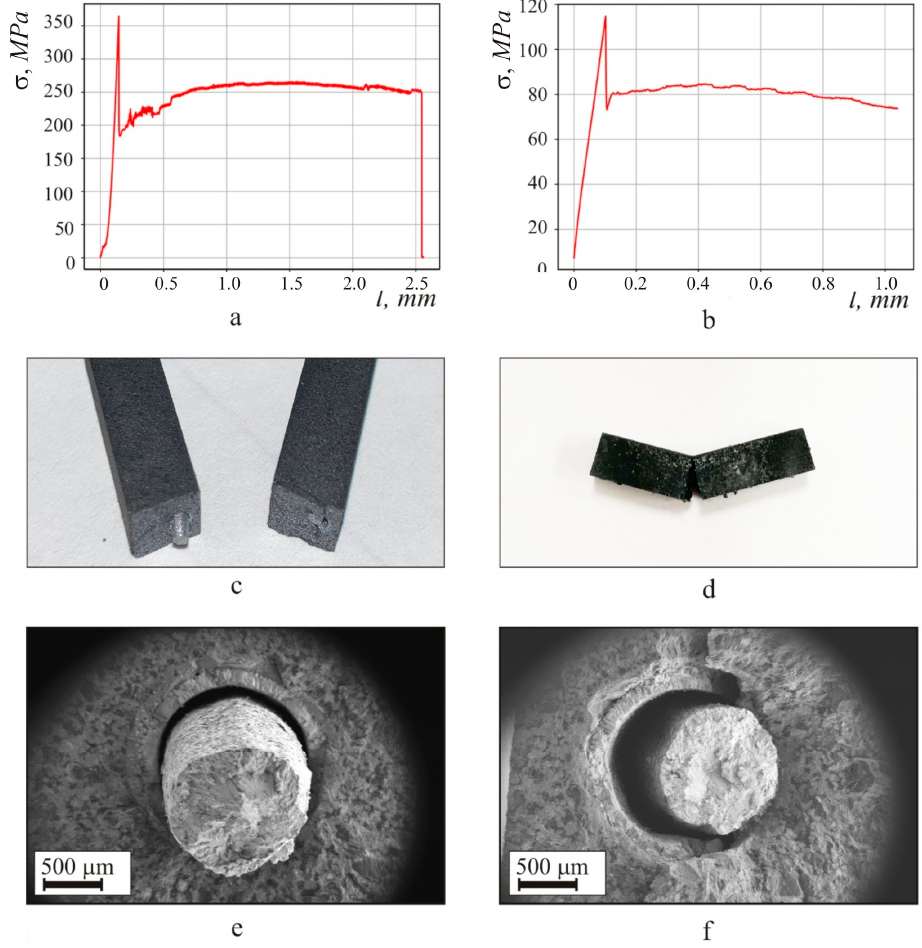
Figure 7. Loading diagrams: ( a ) sample 1–2 at room temperature and ( b ) sample 2–2 at 1500 °C. Photographs of samples after testing: ( c ) sample 1–2 at room temperature and ( d ) sample 2–2 at 1500 °C. ( e , f ) Micrographs of failure surfaces of sample 1–2 after testing.